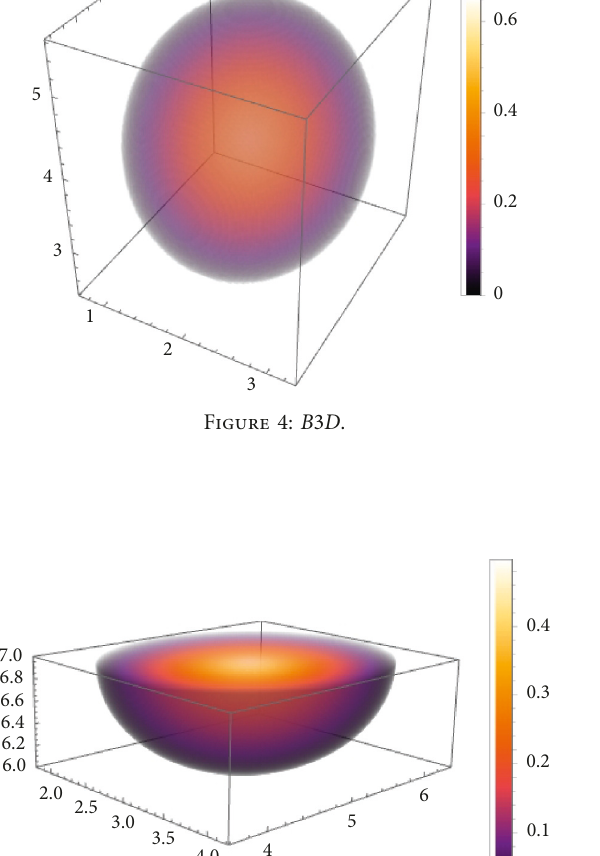
Figure 7: A + B 2 Da − cut .